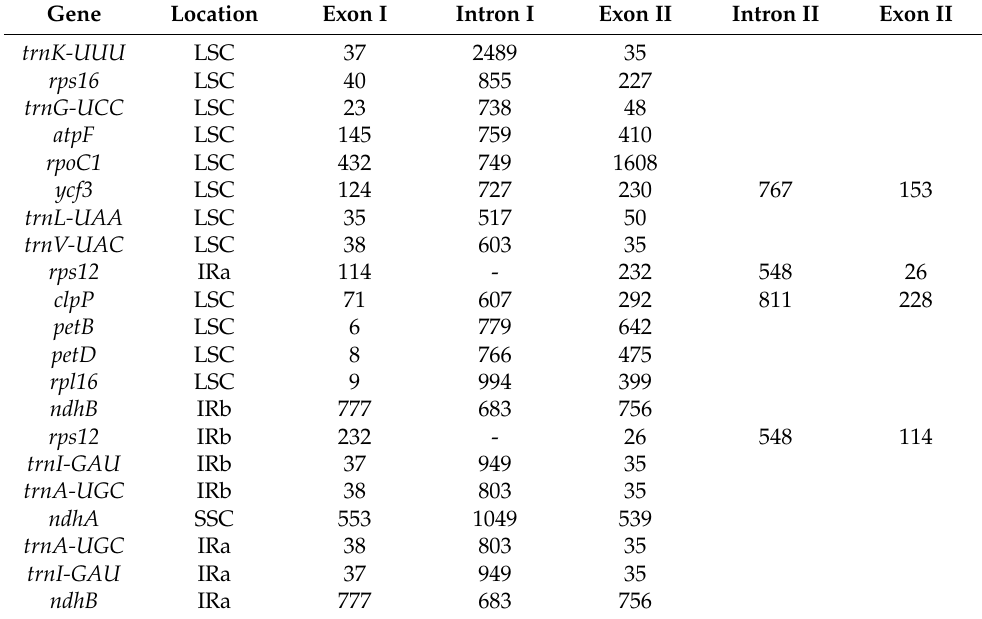
Table 3. Characteristics of the genes that contain intron and exon in the chloroplast (cp) genome of wild